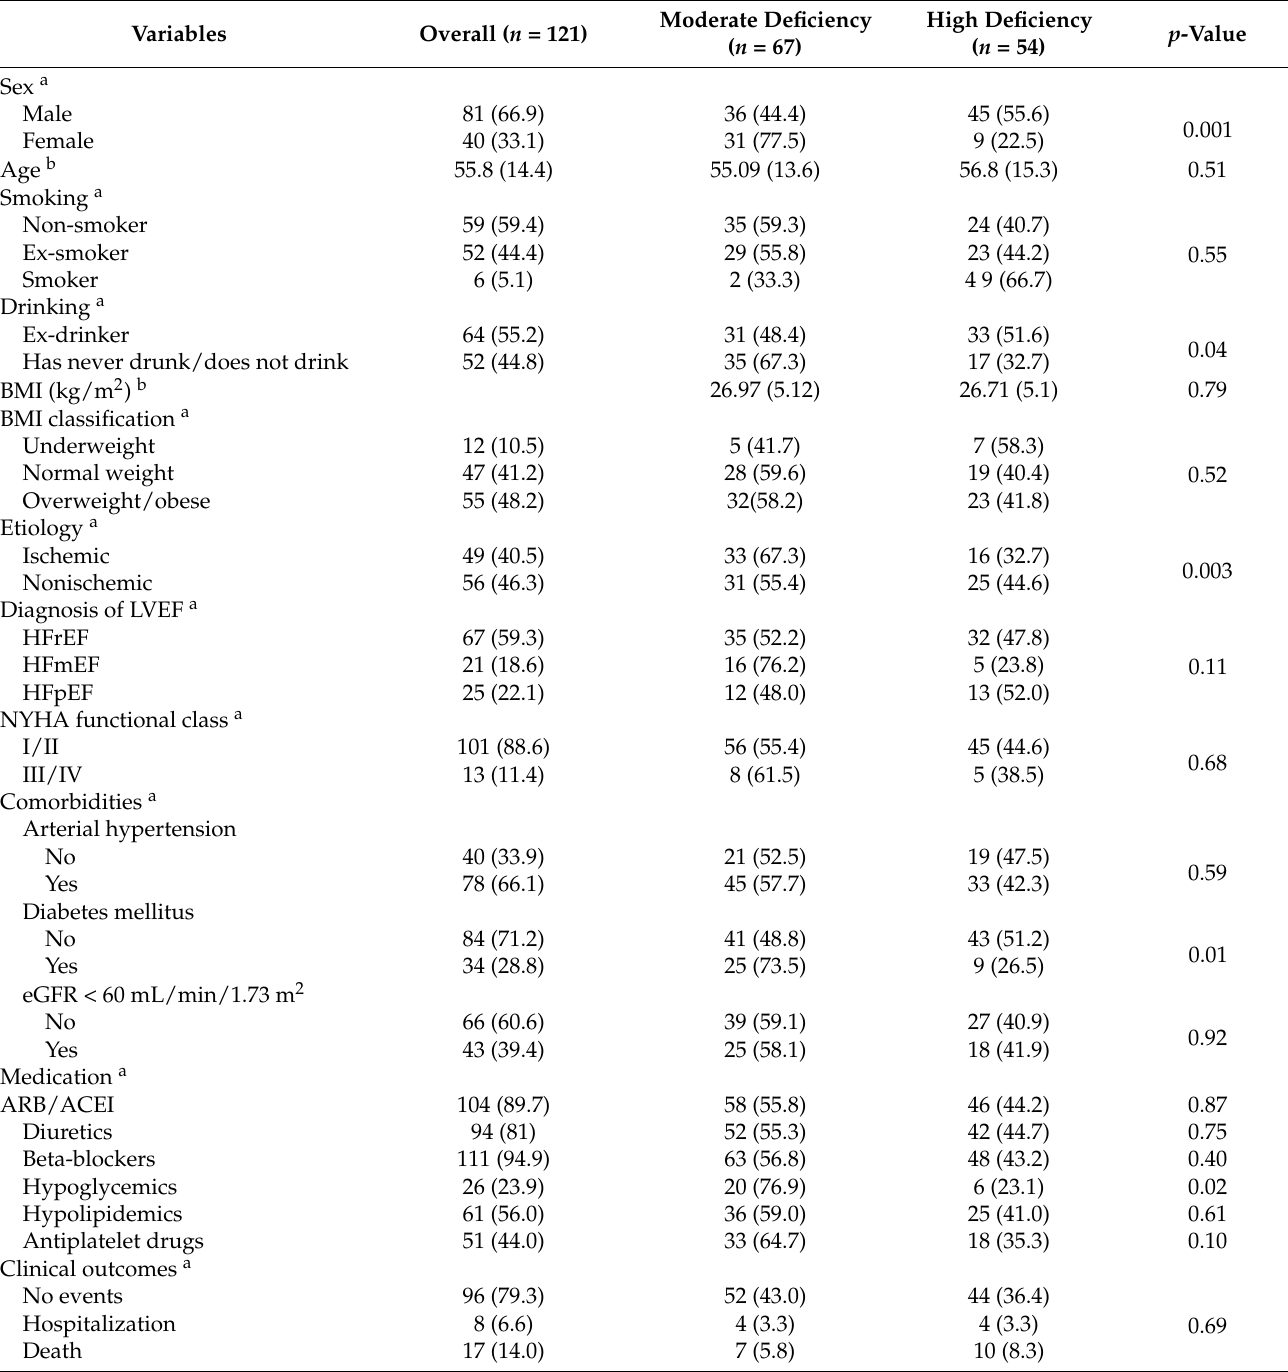
Table 1. Sociodemographic, anthropometric, and clinical characteristics of patients with HF, dis- tributed by micronutrient deficiency